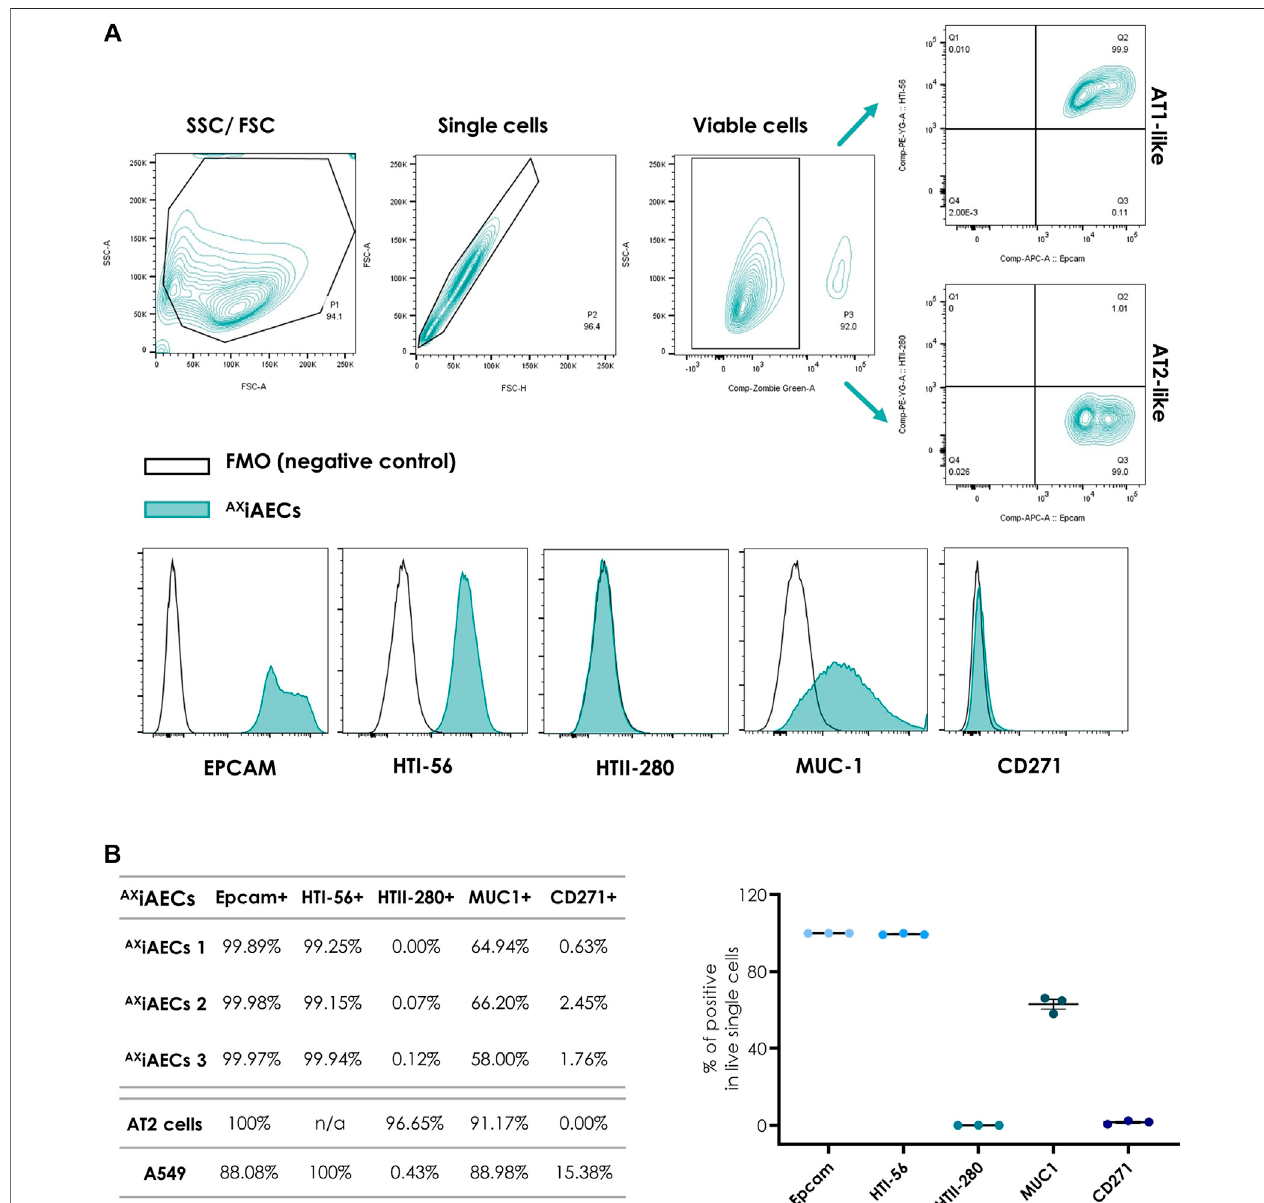
FIGURE 2 | Cell surface phenotype analysis of AX iAECs by fl ow cytometry at D0 (A) FACS gating strategy for identifying distinct alveolar epithelial cell surface markers as indicated in Methods . Fluorescence minus one (FMO) controls were used for all quanti fi cations. Data are representative of three independent experiments. (B) Expressionofcellsurfacemarkersisshownfromthreeindependentexperimentswith AX iAECsandoneexperimentwithhumanAT2cellsandA549cells.Resultsare expressed as a percentage of the live single-cell population. Data are represented as mean ± SEM.